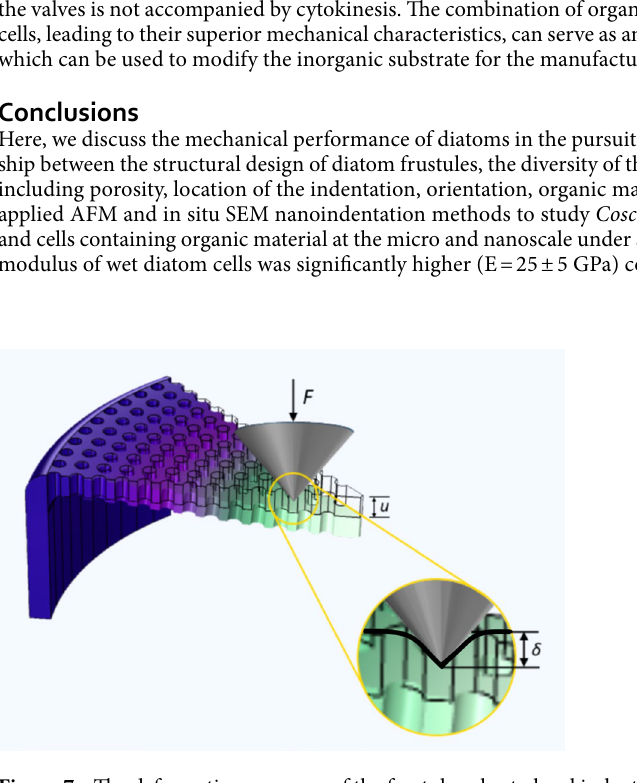
Figure 7. The deformation response of the frustule valve to local